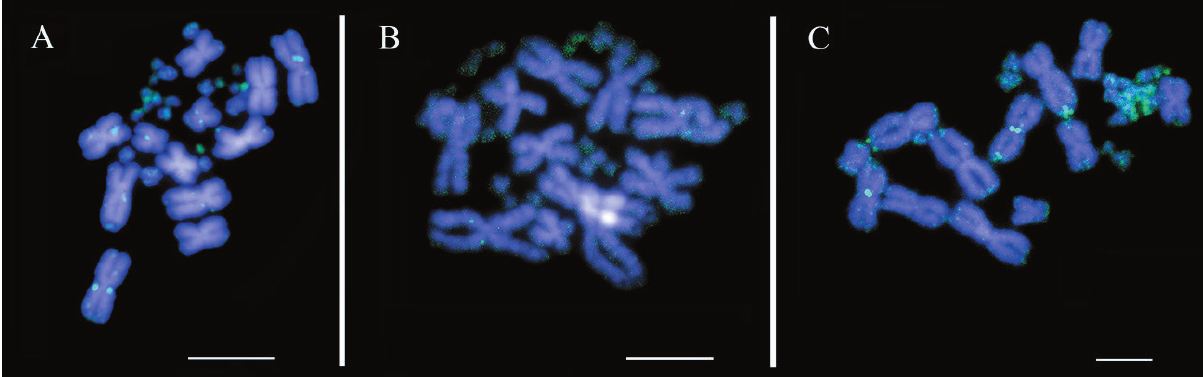
Figure 2. Mitotic chromosomes of Enyalius boulengeri labeled with the repetitive DNA probes: A: (GA) 15 ; B: (GC) 15 ; C: (CAT) 10 . Scale bar indicated 10